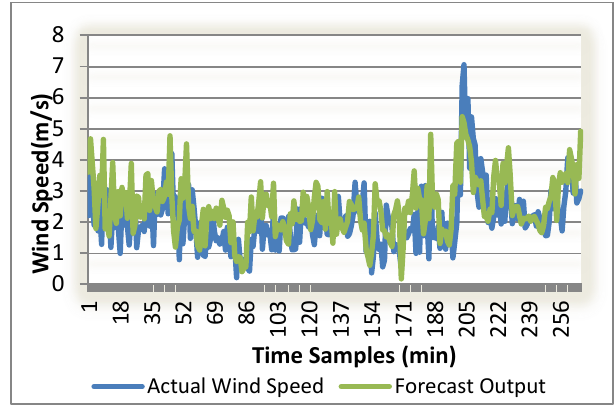
Figure 4 . Actual and forecast wind speed output using RBF with feature selection